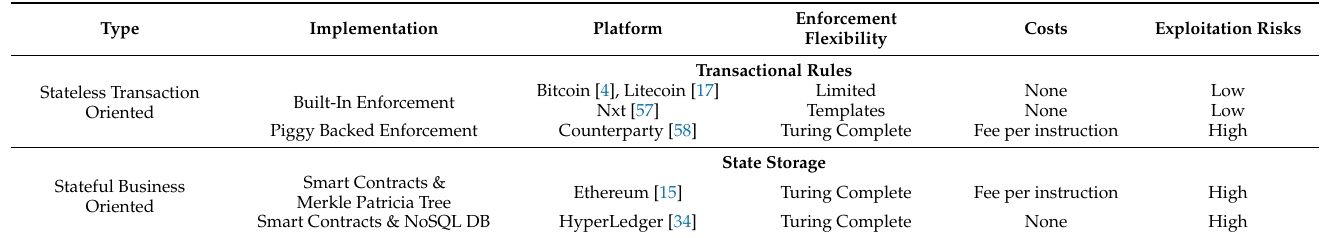
Table 3. Business rules enforcement on